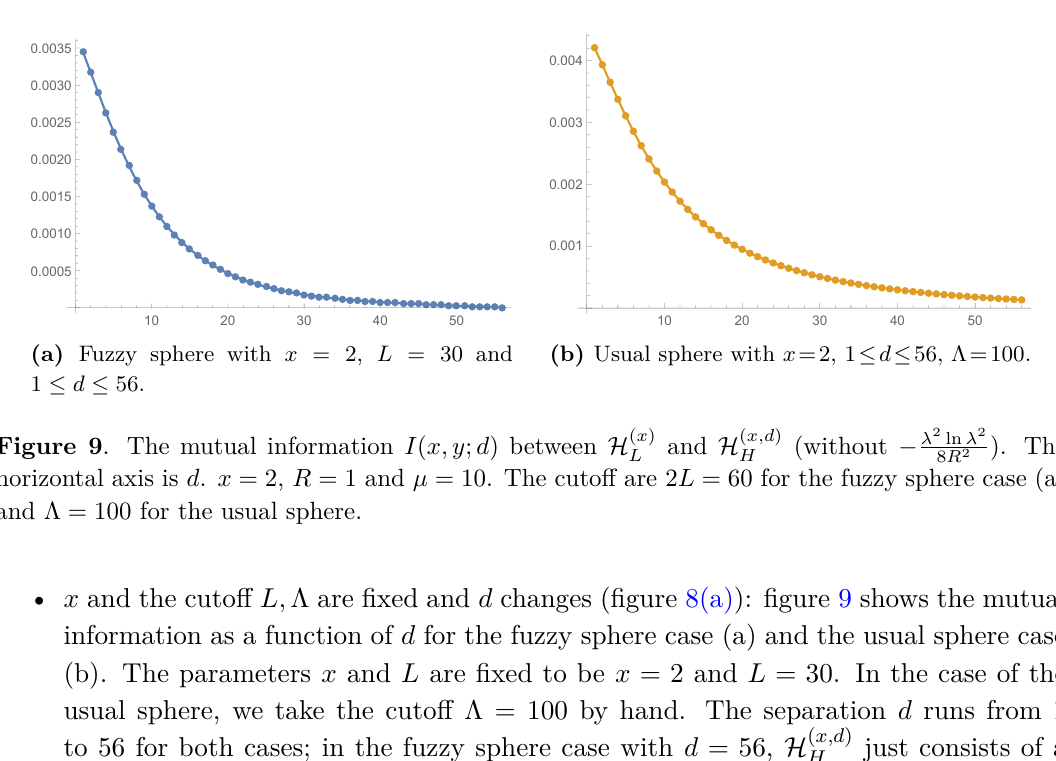
Figure 8 . Two large- d limits of the mutual information. In (a), x and the cutoff Λ are fixed and d is taken to be large. In (b), x and the “size” of H H are fixed and the location of the cutoff 2 L is shifted.